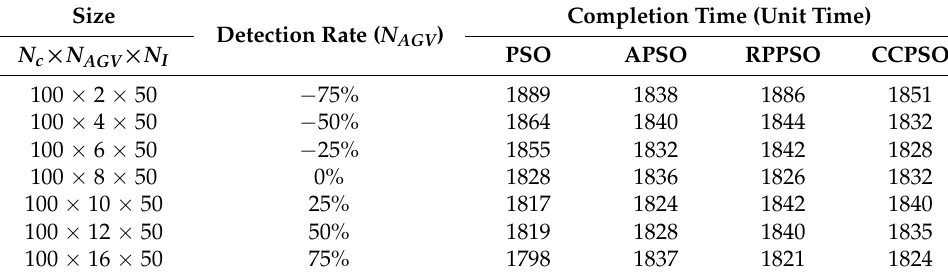
Table 7. Sensitivity test data of AGV quantity allocation.